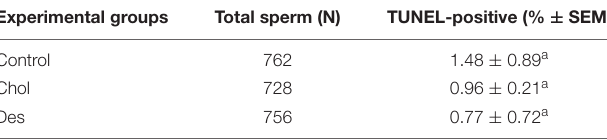
TABLE 1 | Percentages of TUNEL-positive ram sperm after